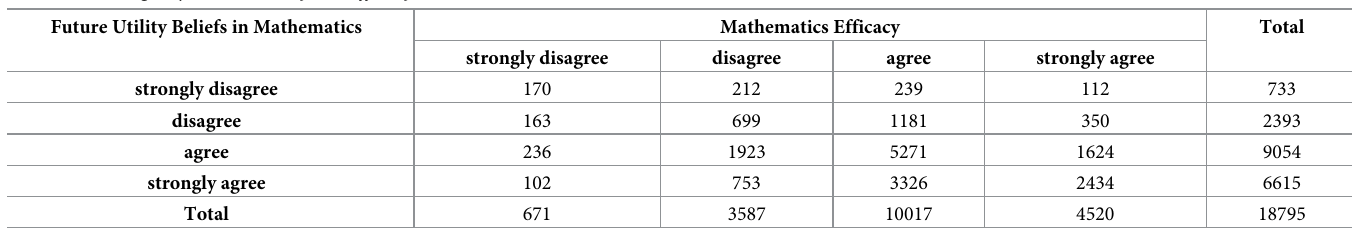
Table 1. Contingency table of Utility and Efficacy .